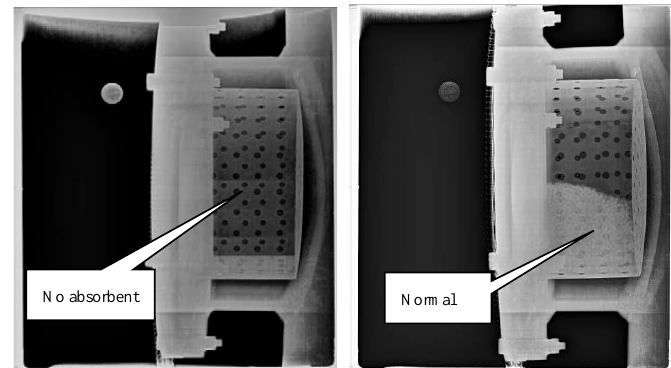
Figure 19. Abnormal and normal absorbent.